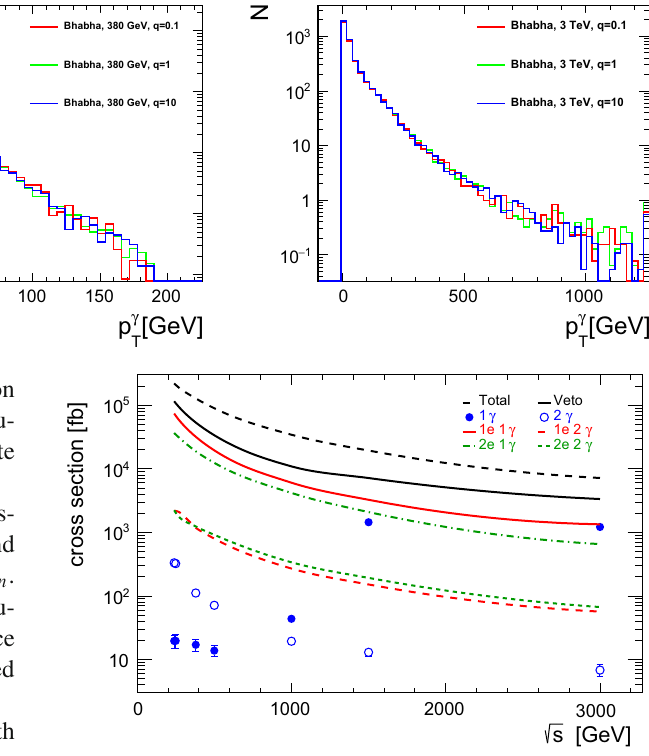
Fig. 8 Cross sections for radiative Bhabha scattering with at least one ‘hard’ photon, after ISR rejection, as a function of the centre-of-mass energy. Cross sections for different final states observed in the central detector, calculated assuming no activity in the BeamCal or LumiCal detectors, are compared with the overall cross section obtained after applying BeamCal and LumiCal cuts (Veto) and the total cross section for the radiative Bhabha scattering (Total), as given in Table